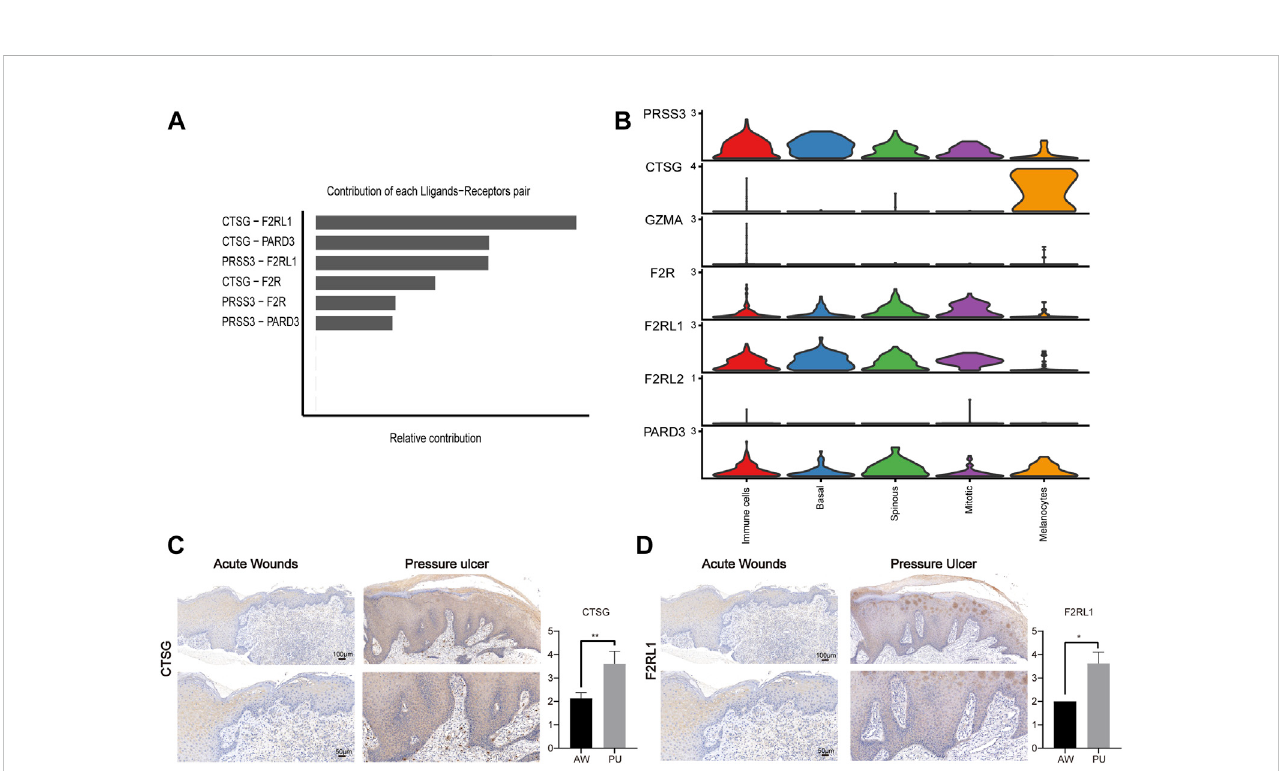
FIGURE 5 TheCTSGandF2RL1expressions increasedinPU. (A) ,Thecontributionofeachligand-receptorpairinthePARs pathwayinPU. (B) ,theexpressionofthe genes related to the PARs pathway. (C) , theimmunohistochemical staining results of CTSGin AW (n = 4) and PU (n = 5) tissue. Data represent the mean± S.D. ** p < 0.01. (Scale bar: 100, 50 μ m). (D) , the immunohistochemical staining results of F2RL1 inAW (n = 4) and PU (n = 5) tissue. Data represent the mean ± S.D. * p < 0.05. (Scale bar: 100, 50 μ m). AW: acute wounds; PU: pressure ulcers.